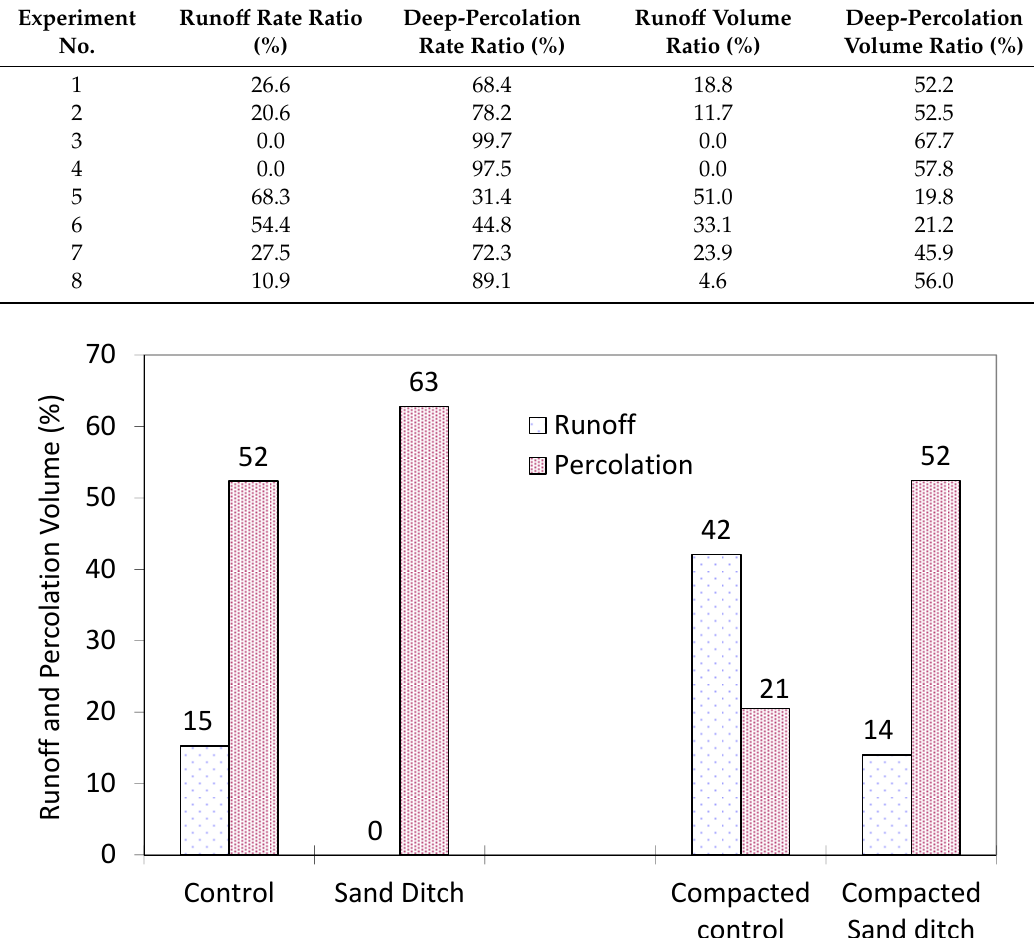
Table 4. The ratios of steady state runoff measured at the surface outlet and deep-percolation rates and volume measured at the drainage face to the corresponding inflow rates and volumes for the experiments.